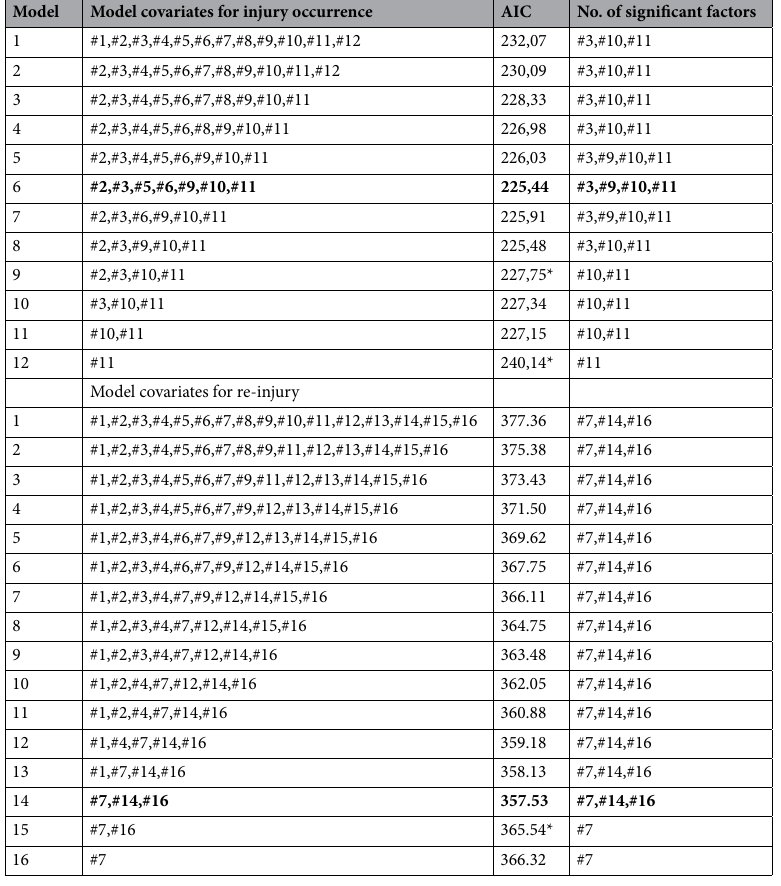
Injured (n = 276) Re-injured (n =